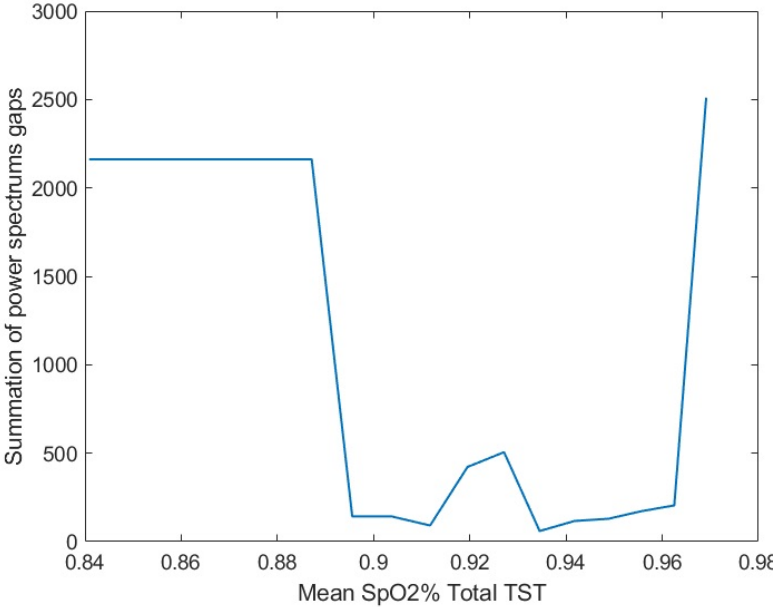
Figure 3. The average gap values among different breathing maneuvers for different thresholds of the mean SpO2% total